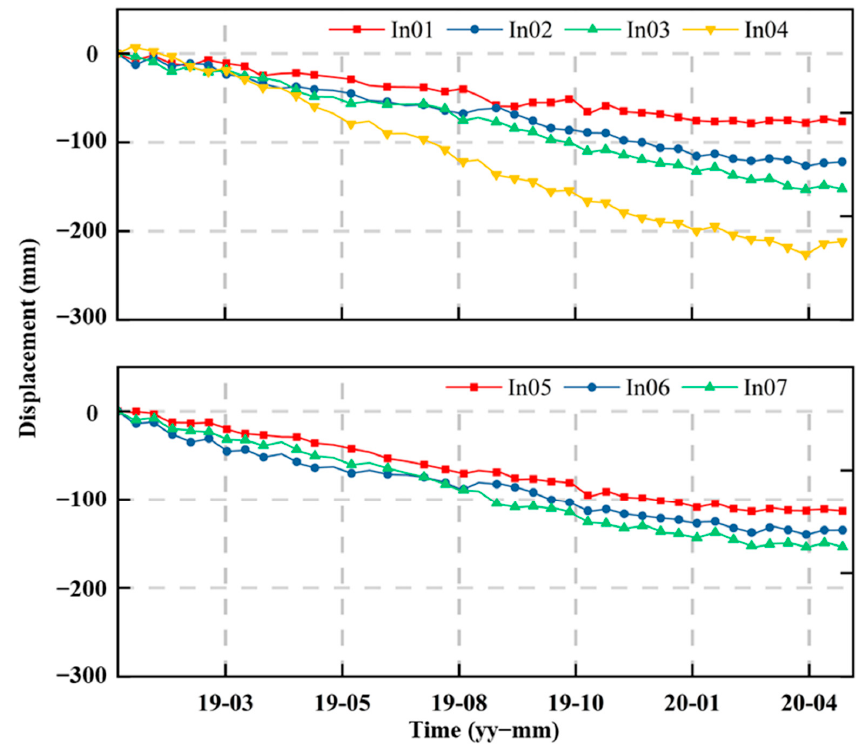
Figure 7. East-west displacement time series of the indicated